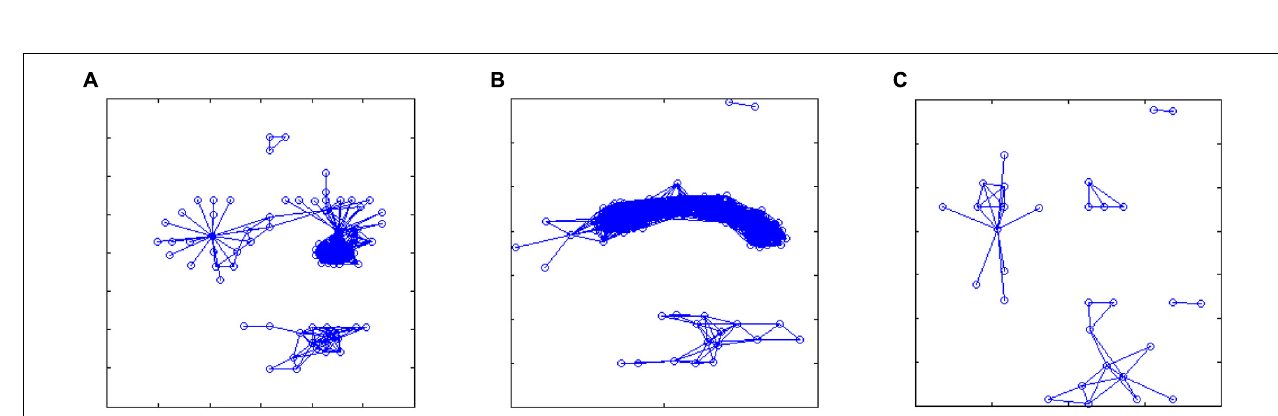
FIGURE 7 | Reconstructed networks in the three cases of Figure 5: (A,B) sleep; (C) dream activity. Starting from the correlation matrices, an arbitrary threshold value was set ( r > 0.8, but the results were qualitatively similar for a broader range of threshold values, from 0.75 to 0.85) in order to define significant links